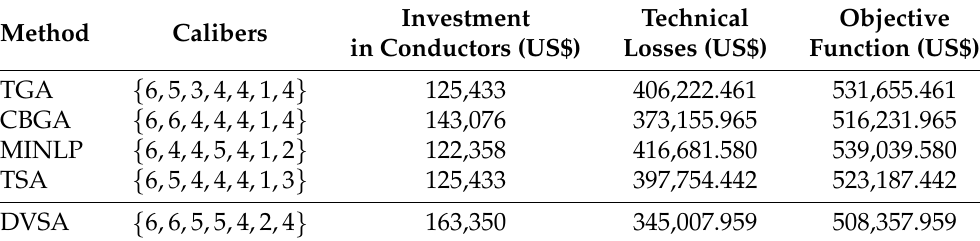
Table 20. Comparative results in the 8-bus systems for the balanced load case for S 1.